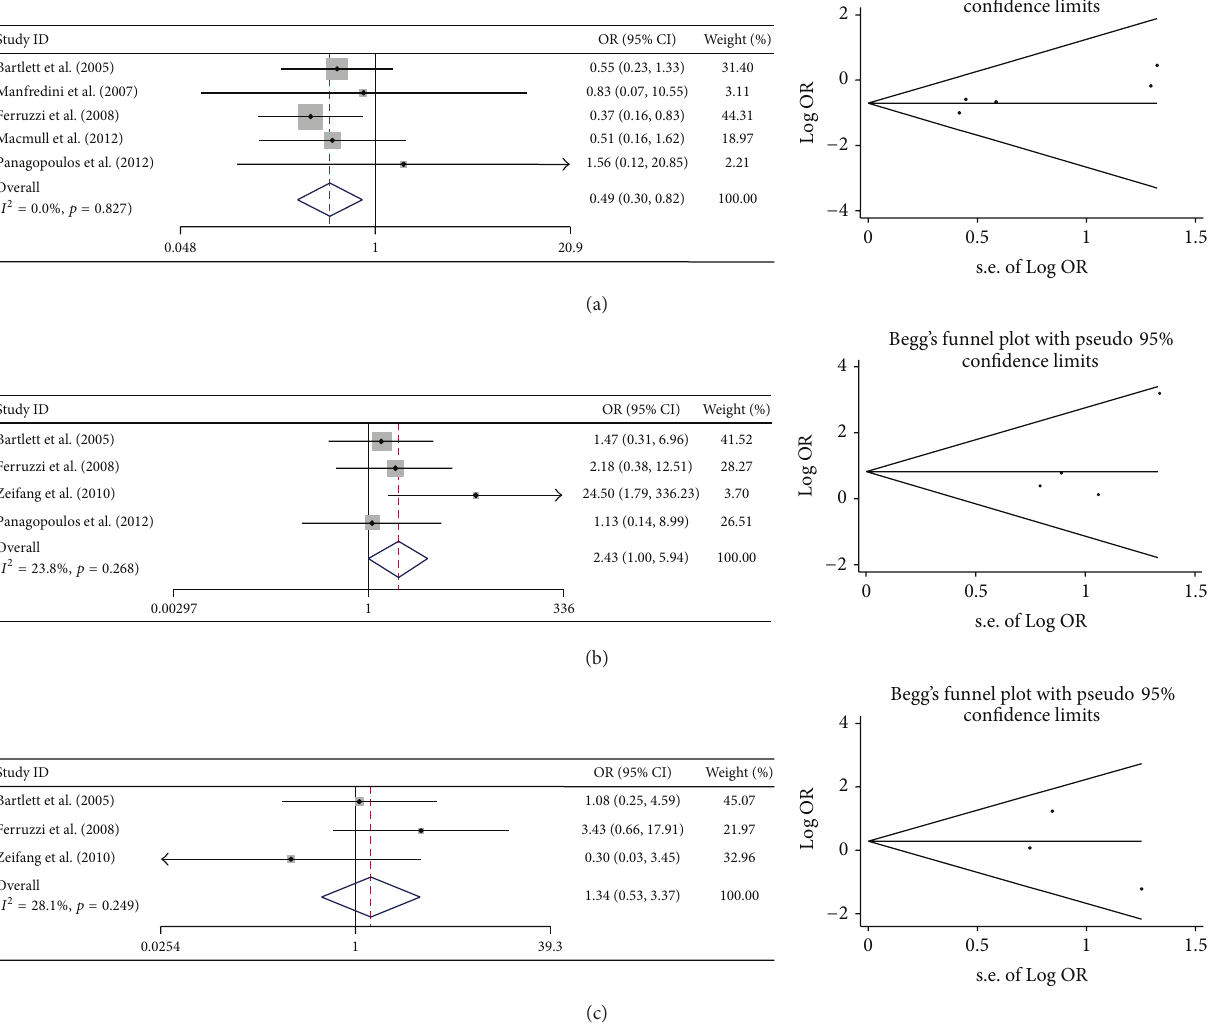
Figure 4: Forest plots and Begg’s funnel plots of studies comparing the traditional ACI with MACT. (a) Forest plots and Begg’s funnel plots conducted by using the number of patients achieved excellent and good results. (b) Forest plots and Begg’s funnel plots conducted by using the incidence of graft hypertrophy. (c) Forest plots and Begg’s funnel plots conducted by using the frequency of